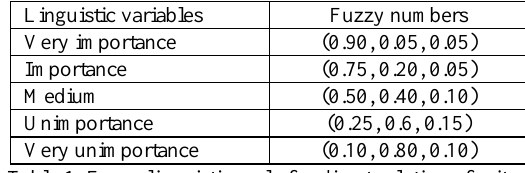
Figure3. Appropriate sites for healthcare services